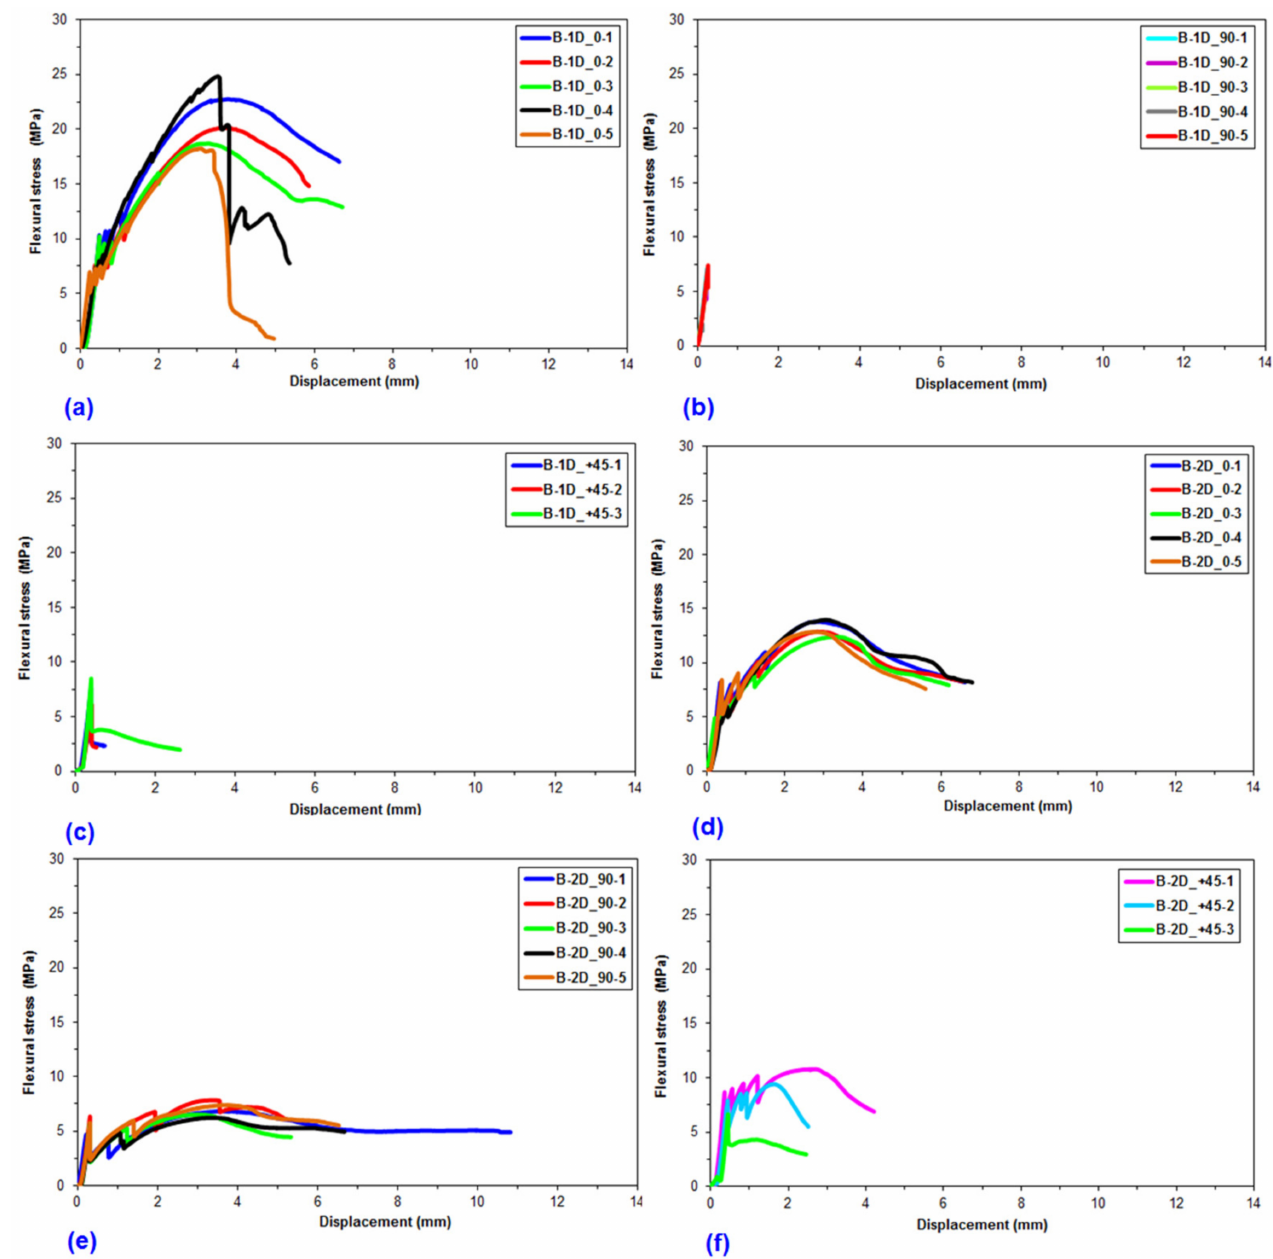
Figure 6. Flexural stress-displacement graph of uniaxial and biaxial 3D basalt concretes. ( a ) B-1D at 0 ◦ flexure test; ( b ) B-1D at 90 ◦ ; ( c ) B-1D at +45 ◦ ; ( d ) B-2D at 0 ◦ ; ( e ) B-2D at 90 ◦ and ( f ) B-2D at +45 ◦